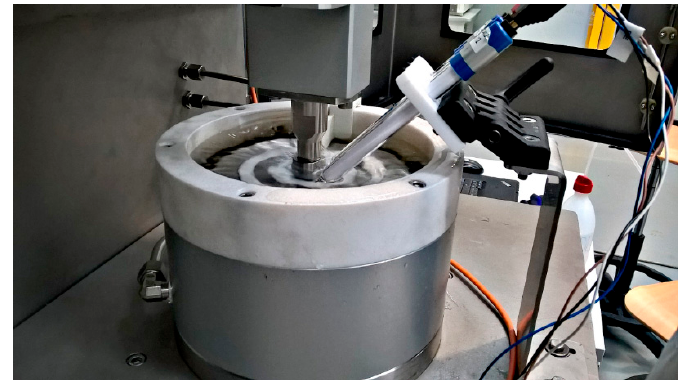
Figure 2. Equipment for the tribocorrosion test.